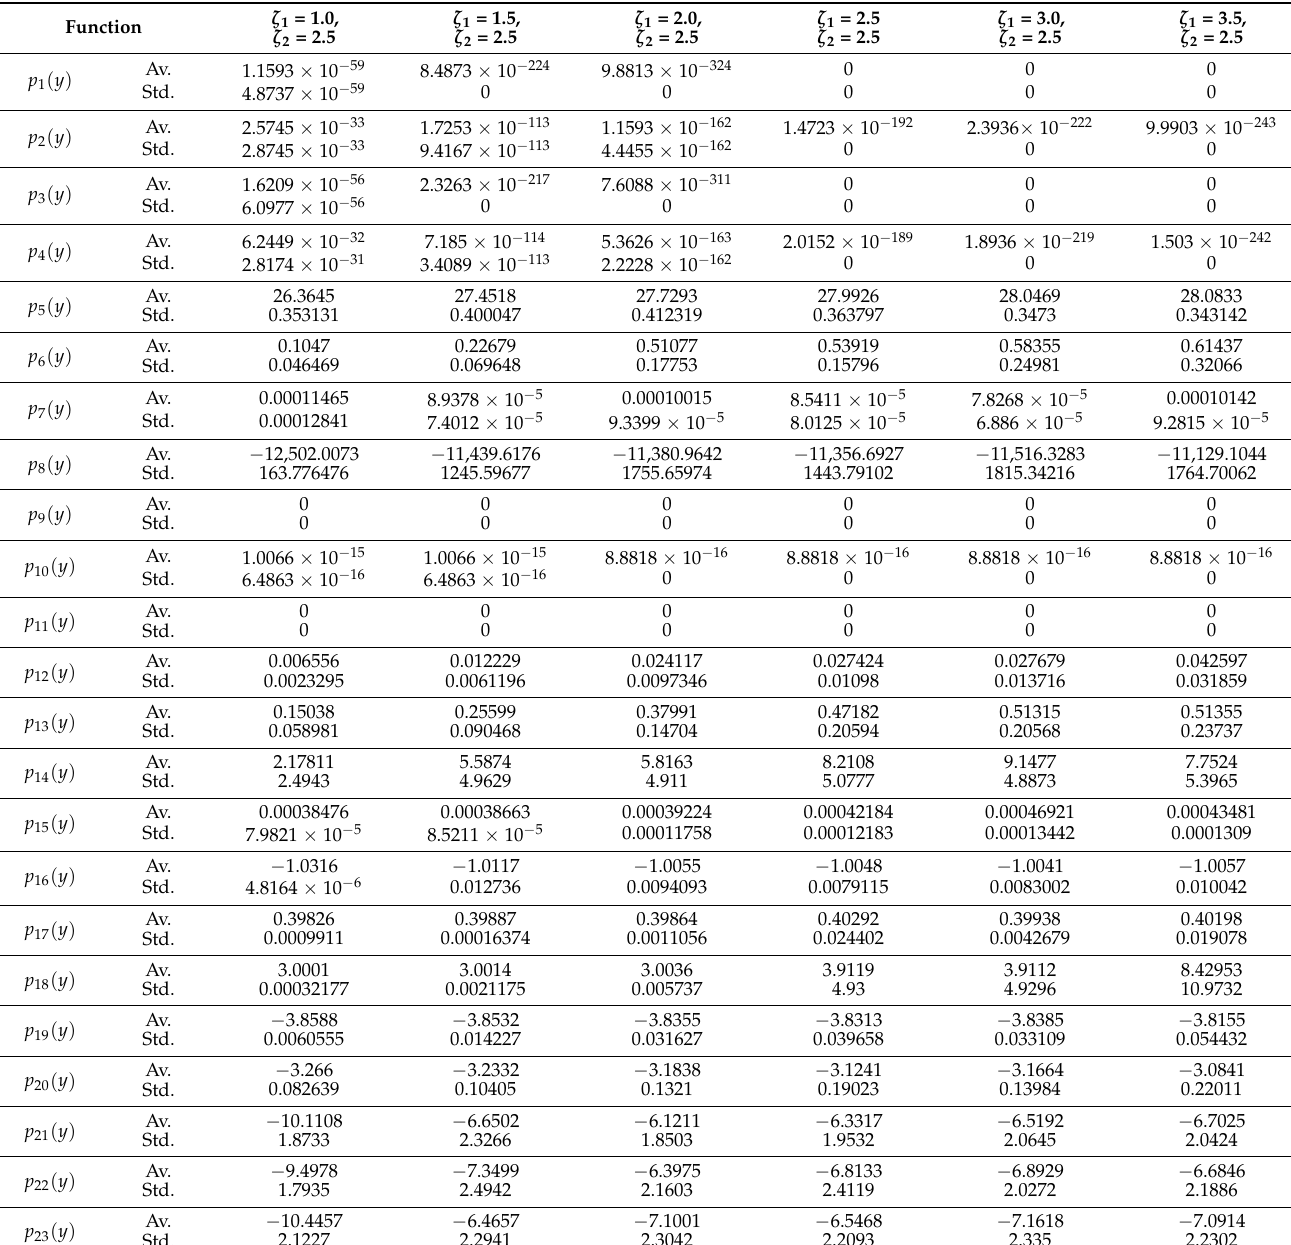
Table A2. ζ 1 is kept fixed at 2.5 and ζ 2 is varied from 1.0 to